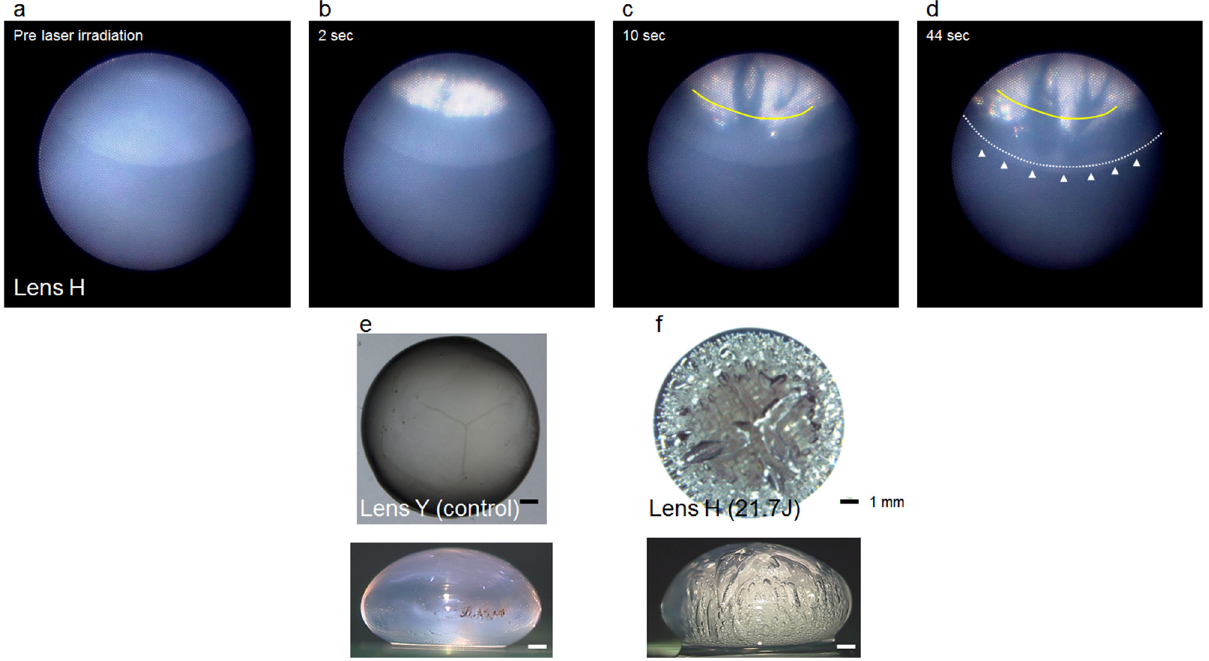
Figure 3. Generated gas by laser irradiation coalesced and moved rearward and beyond the irradiation site, thereby causing the posterior capsule to expand. Excised lens that was irradiated by the laser was expanded as compared to the control lens. ( a – d ) Endoscopic image after laser irradiation in lens H. ( a ) Before laser irradiation. ( b ) At 2 s after laser irradiation. ( c ) After 10 s of laser irradiation. ( d ) At 44 s after laser irradiation. Yellow dotted line indicates the starting position of laser irradiation; white dotted line indicates the posterior capsule position before laser irradiation; white arrowheads indicate posterior capsule position after expansion. ( e , f ) Microscopic image of extracted lens. ( e ) Control lens Y. ( f ) Lens H after laser irradiation. Scale bar is 1 mm. Laser irradiation energy amount listed in parentheses.